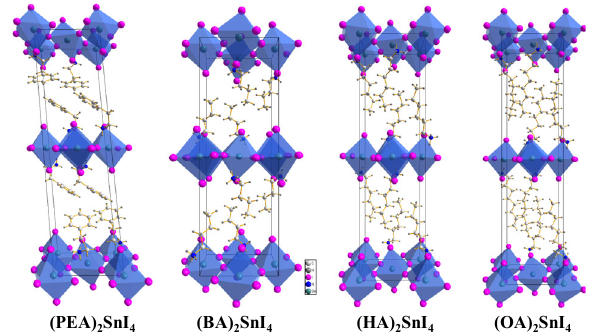
Fig. 1 Crystal structures of four different types of 2D Sn-based perovskites. Two-dimensional Sn − I octahedron layers can be seen stacked on top of each other separated by two layers of organic cations (PEA + , BA + , HA + , and OA + ). Magenta represents I atoms, dark green represents Sn atoms, dark blue represents N atoms, milky white represents C atoms, and gray represents H atoms. The detailed crystal structure data are shown in Supplementary Table 1 and Supplementary Note